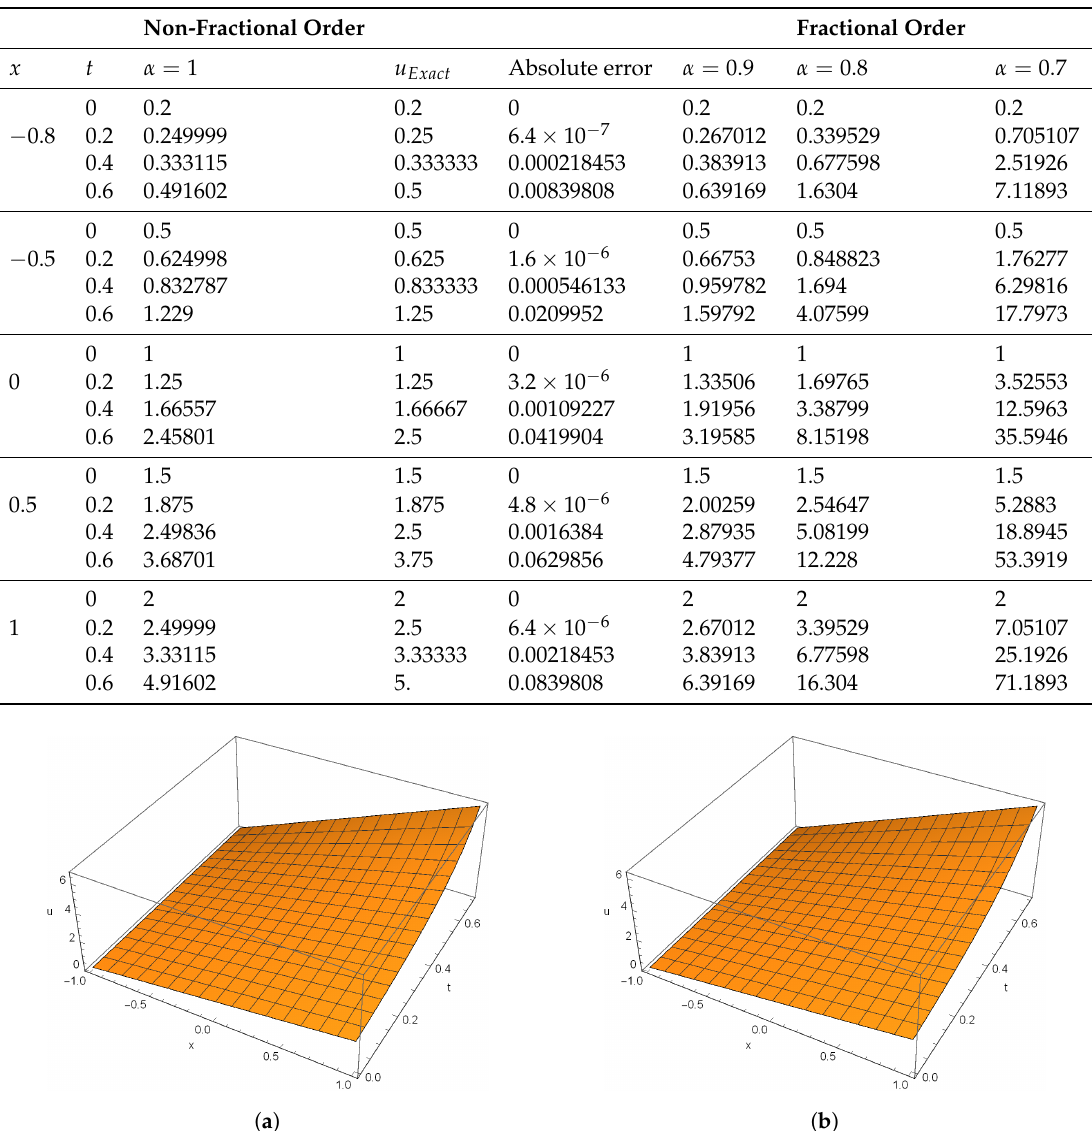
Table 3. Seventh order approximate numerical solutions by FRDTM at different values of α and comparison of absolute errors at α = 1.